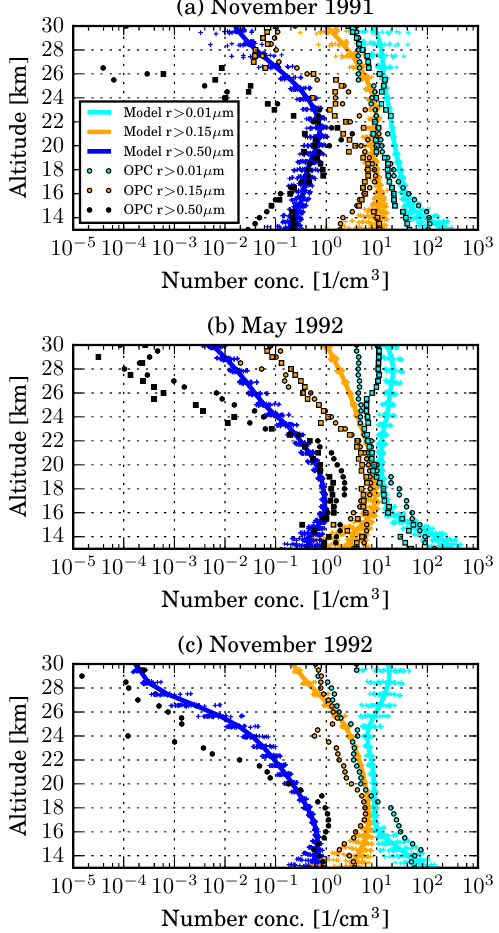
Figure 11. Vertical profile of the cumulative aerosol number con- centration (cm − 3 ) for three channels ( r > 0 . 01µm in light blue, r > 0 . 15µm in orange, and r > 0 . 5µm in dark blue) in Novem- ber 1991, May 1992, and November 1992 at Laramie, Wyoming (41 ◦ N, 105 ◦ W), in the style of Sekiya et al. (2016). Solid lines show the modelled monthly mean, while the crosses indicate the range of daily mean concentrations within that month. Optical par- ticle counter (OPC) measurements from Deshler et al. (2003) are shown as